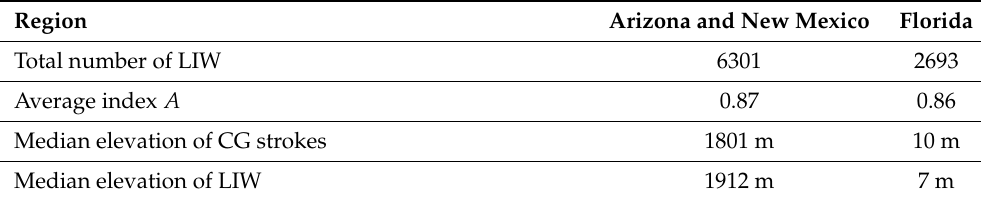
Figure 3. LIW in Florida between 2009 and 2013: ( a ) Monthly distribution of the occurrence of total LIW and CG strokes over slash pine and baldcypress. ( b ) Frequency distribution of the peak currents of all CG strokes taking place over slash pine and baldcypress forests in June and September (black) and of all fire-igniting lightning flashes (red) detected with NLDN. ( c ) Distribution of the distance between the reported position of ignition and the lightning candidate. ( d ) Distribution of the holdover. Table 2. Main characteristics of LIW in Arizona and New Mexico as well as in